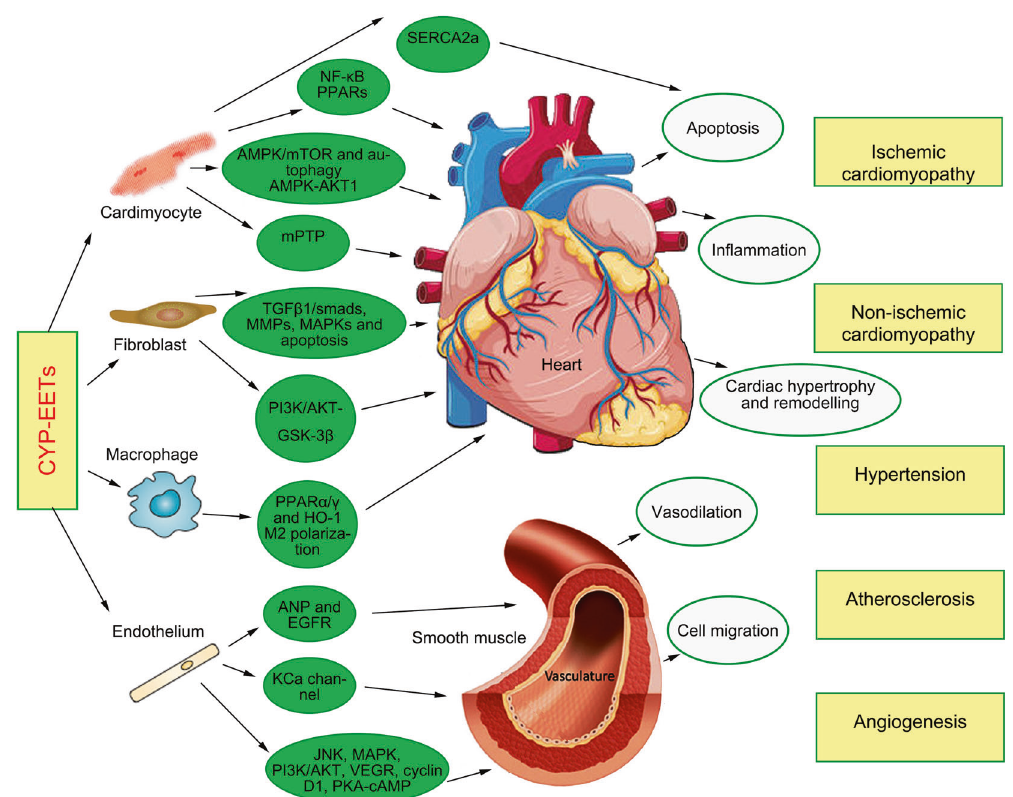
Fig. 2 The main biological functions of CYP-EETs on the cardiovascular system and the main corresponding cellular signaling pathways. CYP epoxygenase metabolites of AA, EETs, act as lipid mediators eliciting numerous biological responses and impacting both vascular and cardiac function, including anti-apoptosis, anti-in fl ammation, vasodilation, inducing angiogenesis, anti-hypertension and aginst ischemic cardiomyopathy or non-ischemic